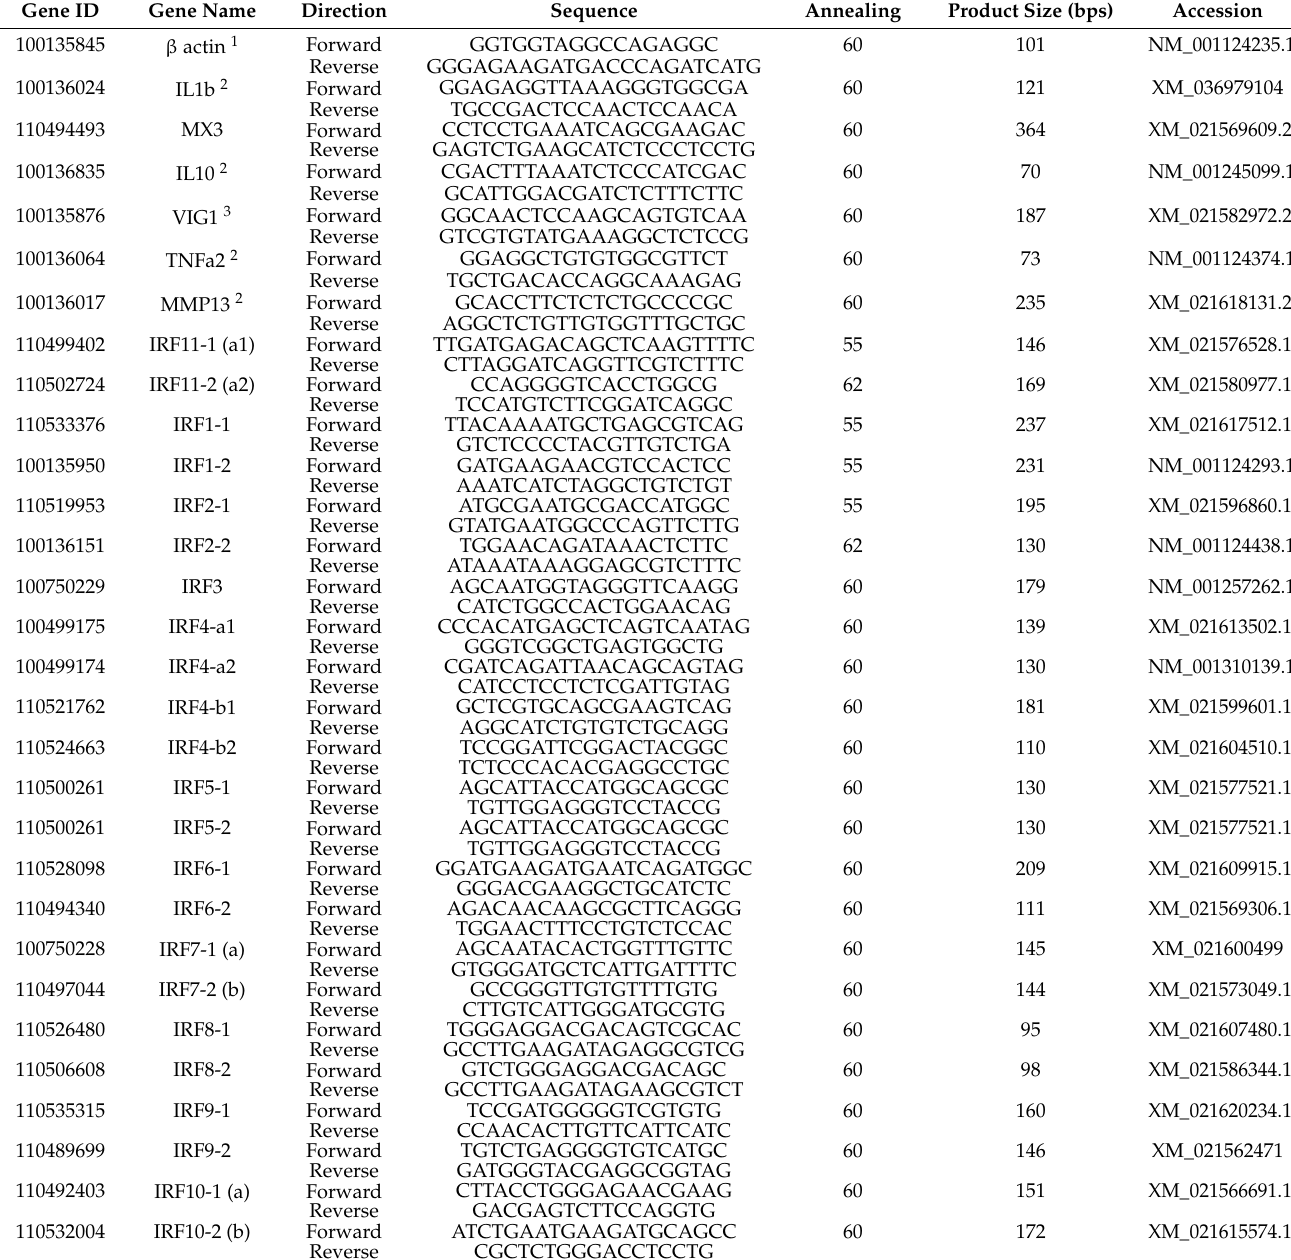
Table 1. Rainbow trout primer sequences used for qPCR with gene IDs and NCBI accession